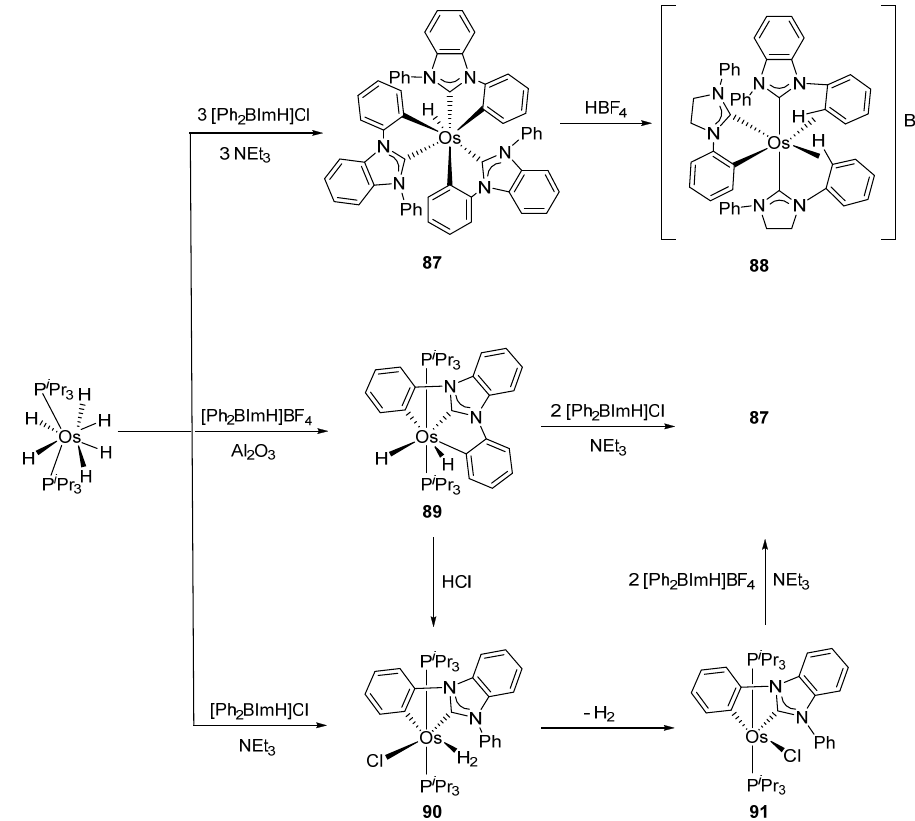
Figure 18. Synthetic routes to tris -cyclometalated complexes from mono -cyclometalated deriva- tives. 3.4. [Os( η 6 -arene)Cl 2 ] 2